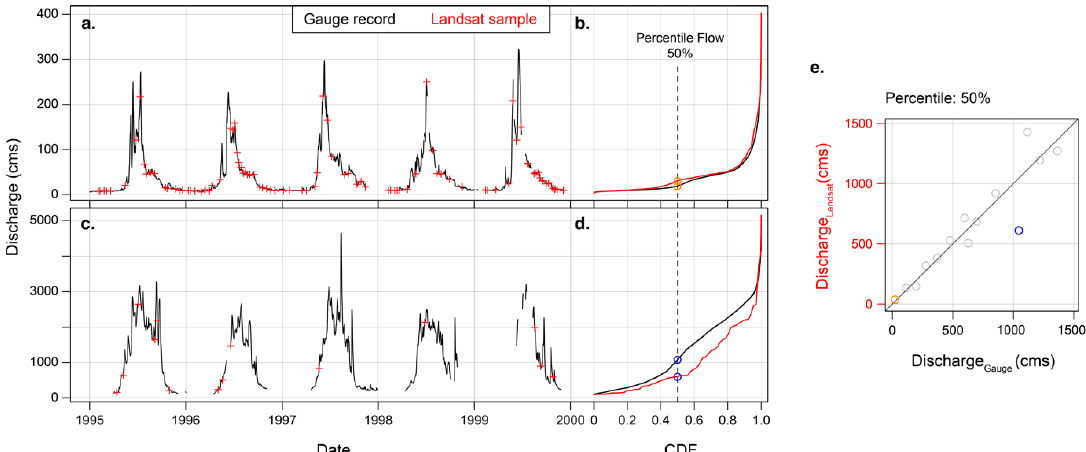
Figure 2. Hydrographs, cumulative density functions (CDFs), and a percentile plot from two example gauge stations. For visual clarity, hydrographs show a 5 year subset of the full record (1984–2019), while CDFs correspond to the full record length. Gaps in the hydrographs correspond to United States Geological Survey (USGS) flow observations that are estimated, provisional, and / or frozen. ( a ) Hydrograph of USGS Gauge 06225500 at Wind River near Crowheart, Wyoming, and ( b ) the corresponding flow frequency CDF (KSD statistic = 0.09, p -value < 0.001). ( c ) USGS Gauge 15129000 at Alsek River near Yakutat, Alaska, and ( d ) the corresponding flow frequency CDF (KSD statistic = 0.17, p -value = 0.055). ( e ) Fiftieth percentile (median) flow calculated from the full gauge record (x-axis) vs. from the Landsat sample (y-axis), with the two example gauge stations represented as colored circles. Gray circles represent median flows from other gauge stations.